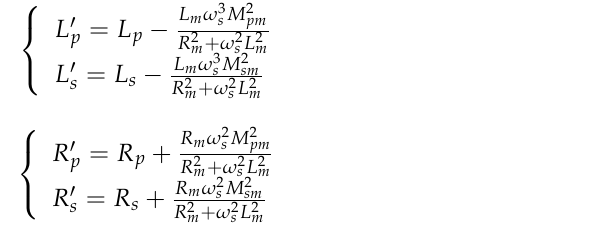
Figure 4. Equivalent circuit of MOD. Resonant capacitor parameters need to be matched in the absence of a metal foreign object, as follows: